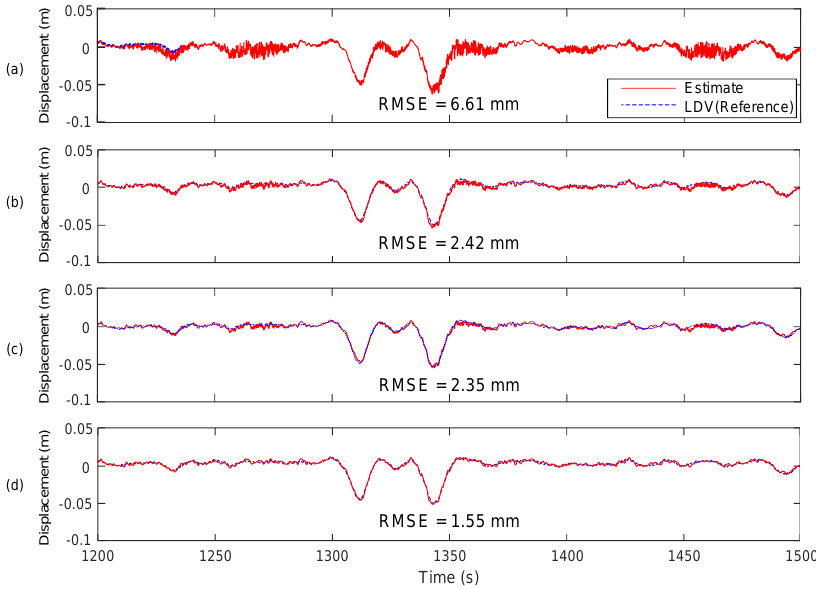
Figure 14. Comparison of the proposed method with other data fusion techniques: ( a ) Smyth and Wu [24]; ( b ) Kim et al. [25]; ( c ) Kim et al. [27] and; ( d ) the proposed system.